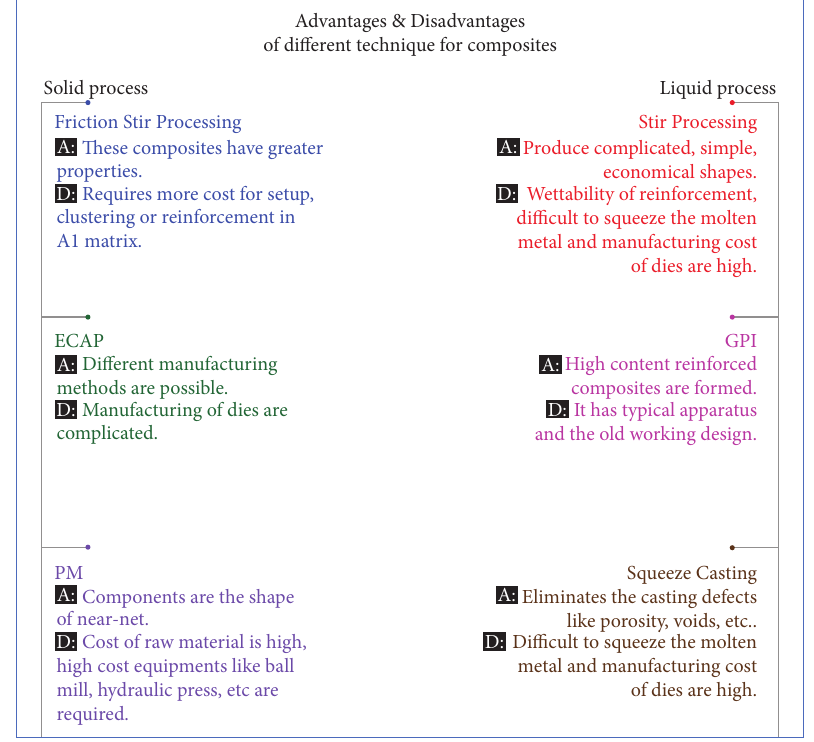
Figure 3: Advantages and disadvantages of different techniques for